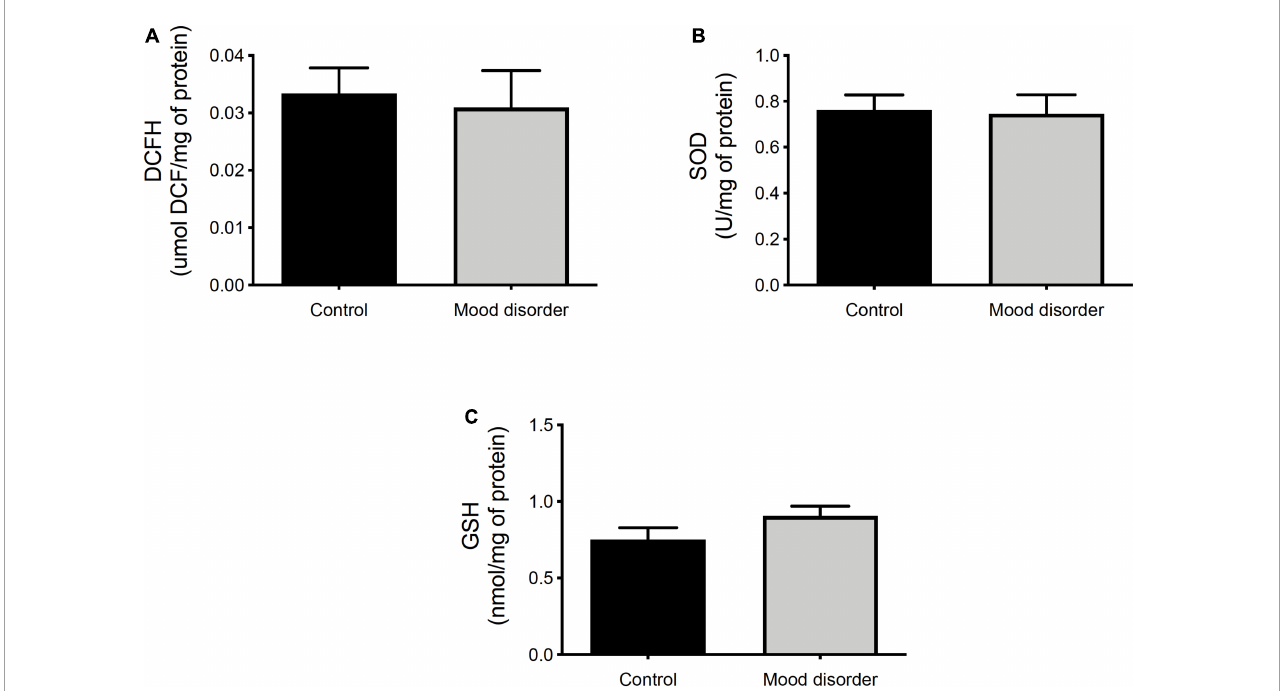
FIGURE2 Oxidative stress analysis in plasma of women (control, N = 15 and mood disorder, N = 30) at 18 months postpartum. (A) DCFH is expressed as µ mol/mg of protein; (B) superoxide dismutase (SOD) activity is expressed as U/mg of protein; and (C) GSH content is expressed as nmol/mg of protein. Statistical analysis was analyzed by t